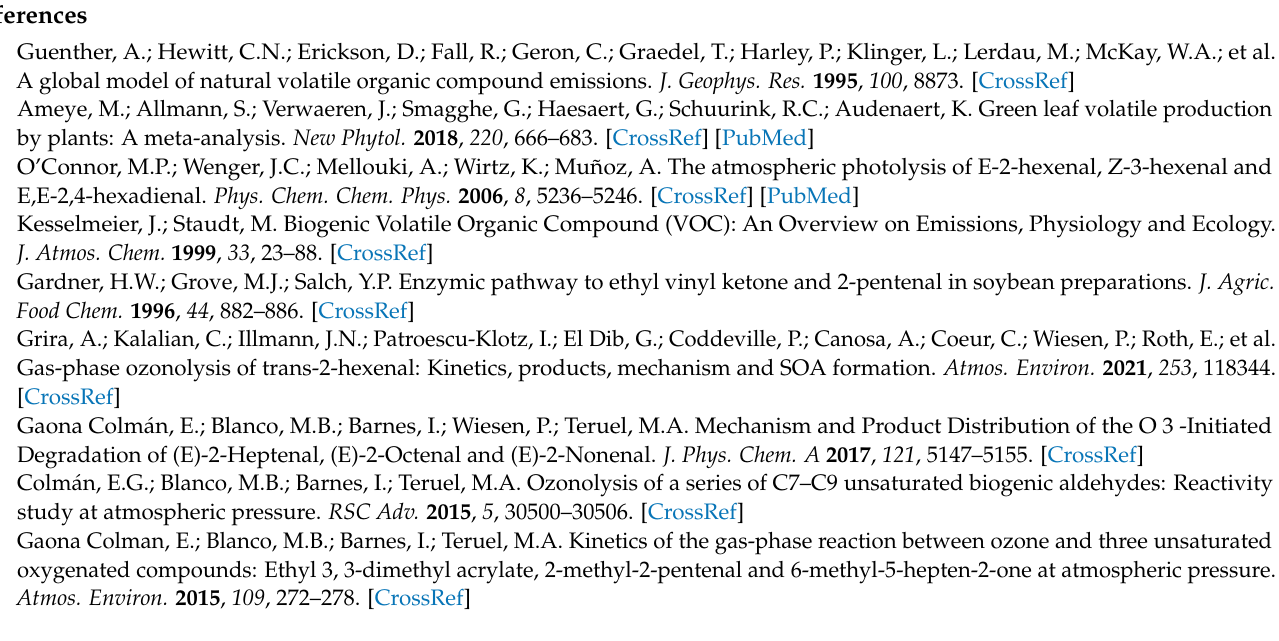
temperature (T = 298 K) obtained in LFR. Error bars correspond to 1 σ . Figure S3. IR spectra from QUAREC. From bottom to top: Panel A shows the IR spectrum of a mixture air/T2P. Panel B shows the IR spectrum at the end of the reaction, including the product. Panels C, D and E show the reference spectra of propanal, glyoxal, and acetaldehyde. Panel F shows the resulting IR spectrum after removing the residual T2P and O 3. Figure S4. Temporal evolution of T2P and the products identified by FTIR during ozonolysis in QUAREC. Figure S5. Temporal evolution of T2P and the products identified by SPME-GC / MS and FTIR during ozonolysis in RASC. Figure S6. OH production in two T2P + O3/mesitylene experiments (BUW). The error bars represent the errors due to evaluation and calibration procedures, 15% and 10% for T2P and mesitylene, respectively. Table S1: Data for Figure 1. Table S2: Data for Figure 2. Table S3: Data for Figure 3. Table S4. The Z-matrices, energies (in Hartree), imaginary frequencies of TS structures and multiplicity of all the optimized structures at M06-2X/6-311++G(d,p) level of